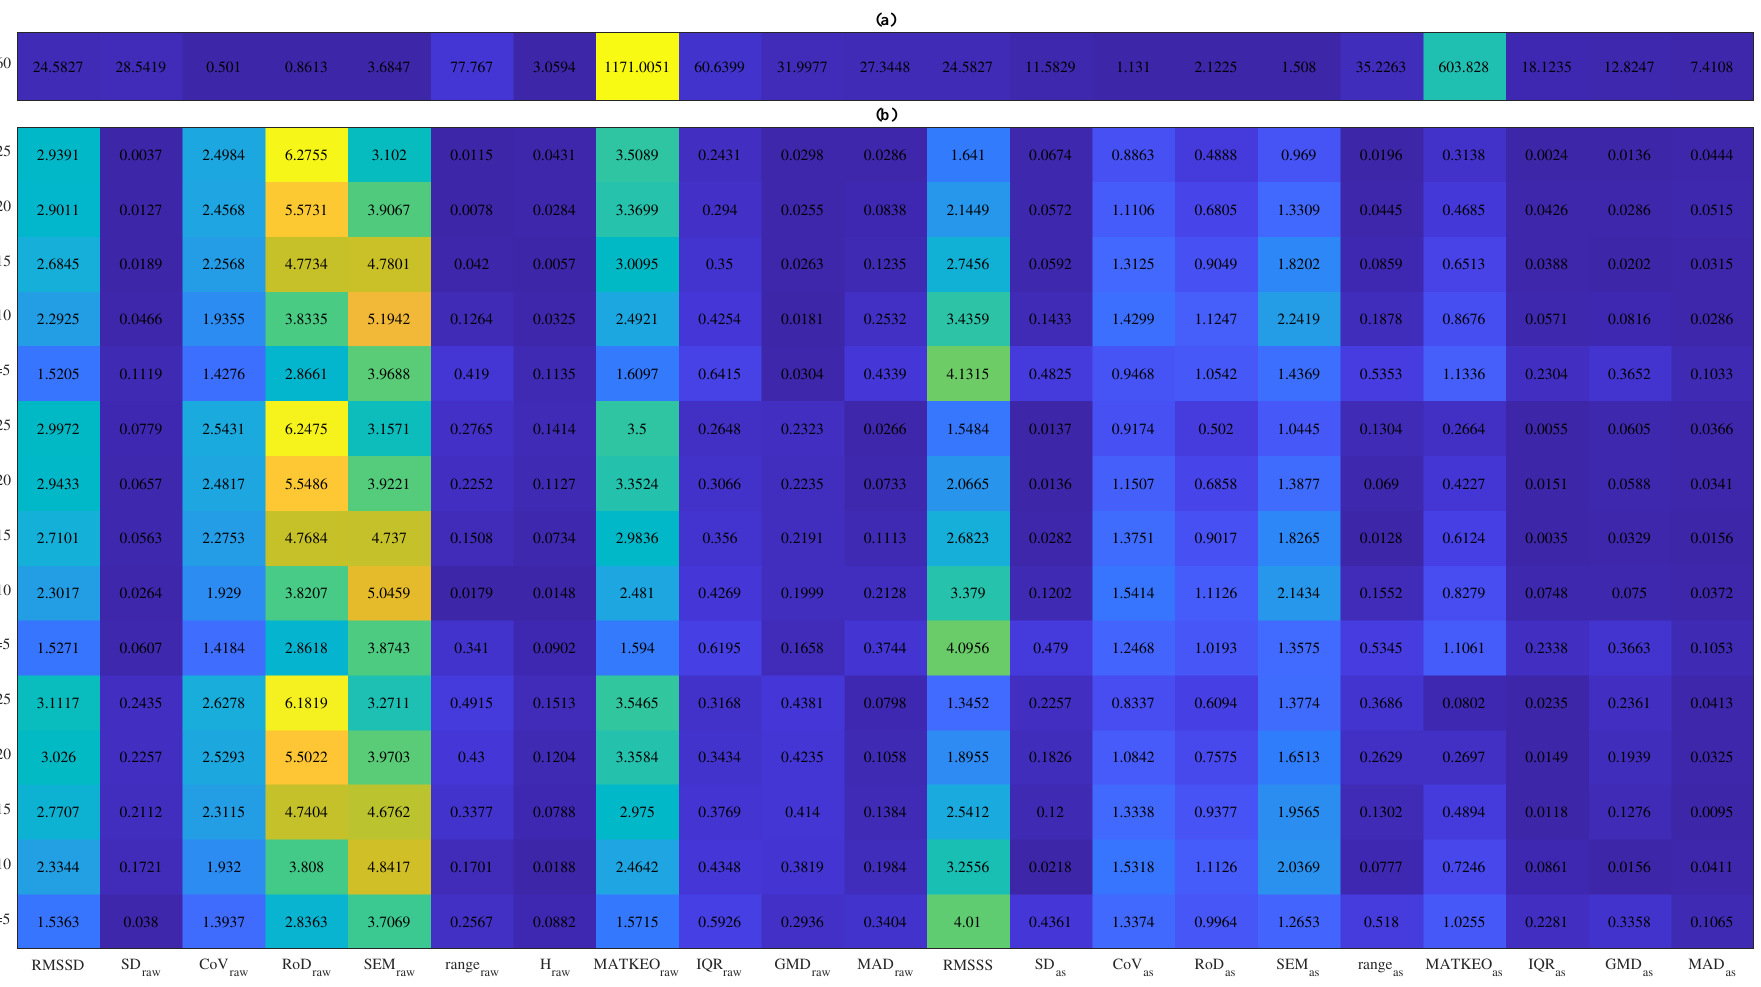
Figure 5. Results for 4000 realizations with a cosine function with amplitude 40. The meaning of all quantities can be found in the table of abbreviations. ( a ) Mean values in a favorable scenario. ( b ) Performance